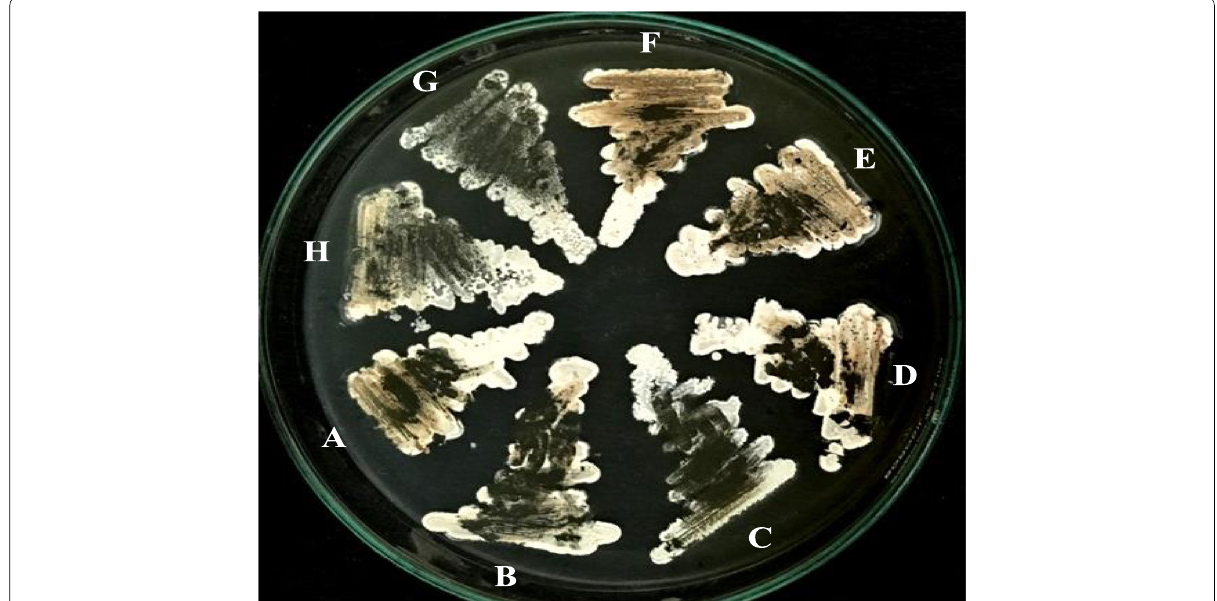
Fig. 6 Phenotypic appearance of Streptomyces strain JB140 WT ( A ) and its evolved mutants JB140 St ( B ), JB140 Sa ( C ), JB140 Pv ( D ), JB140 Sa,St ( E ),